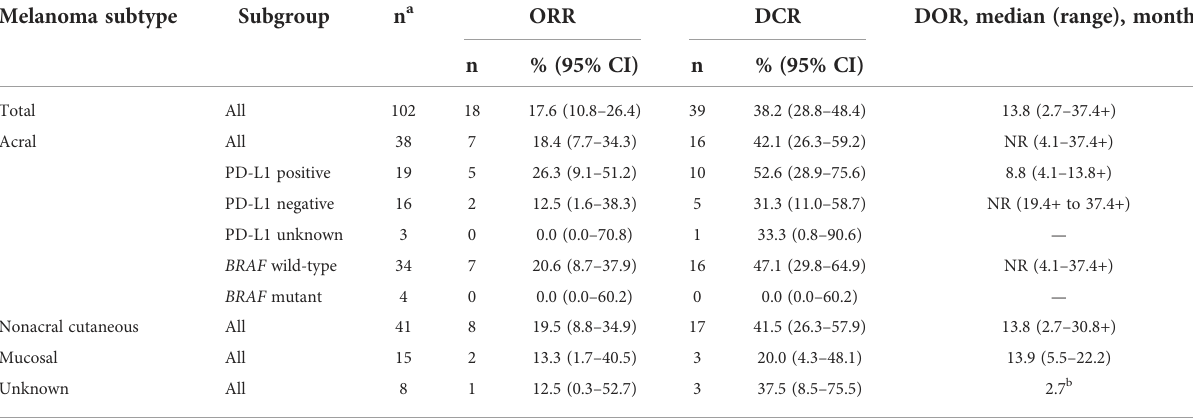
TABLE 3 Response characteristics per RECIST v1.1 by BICR.